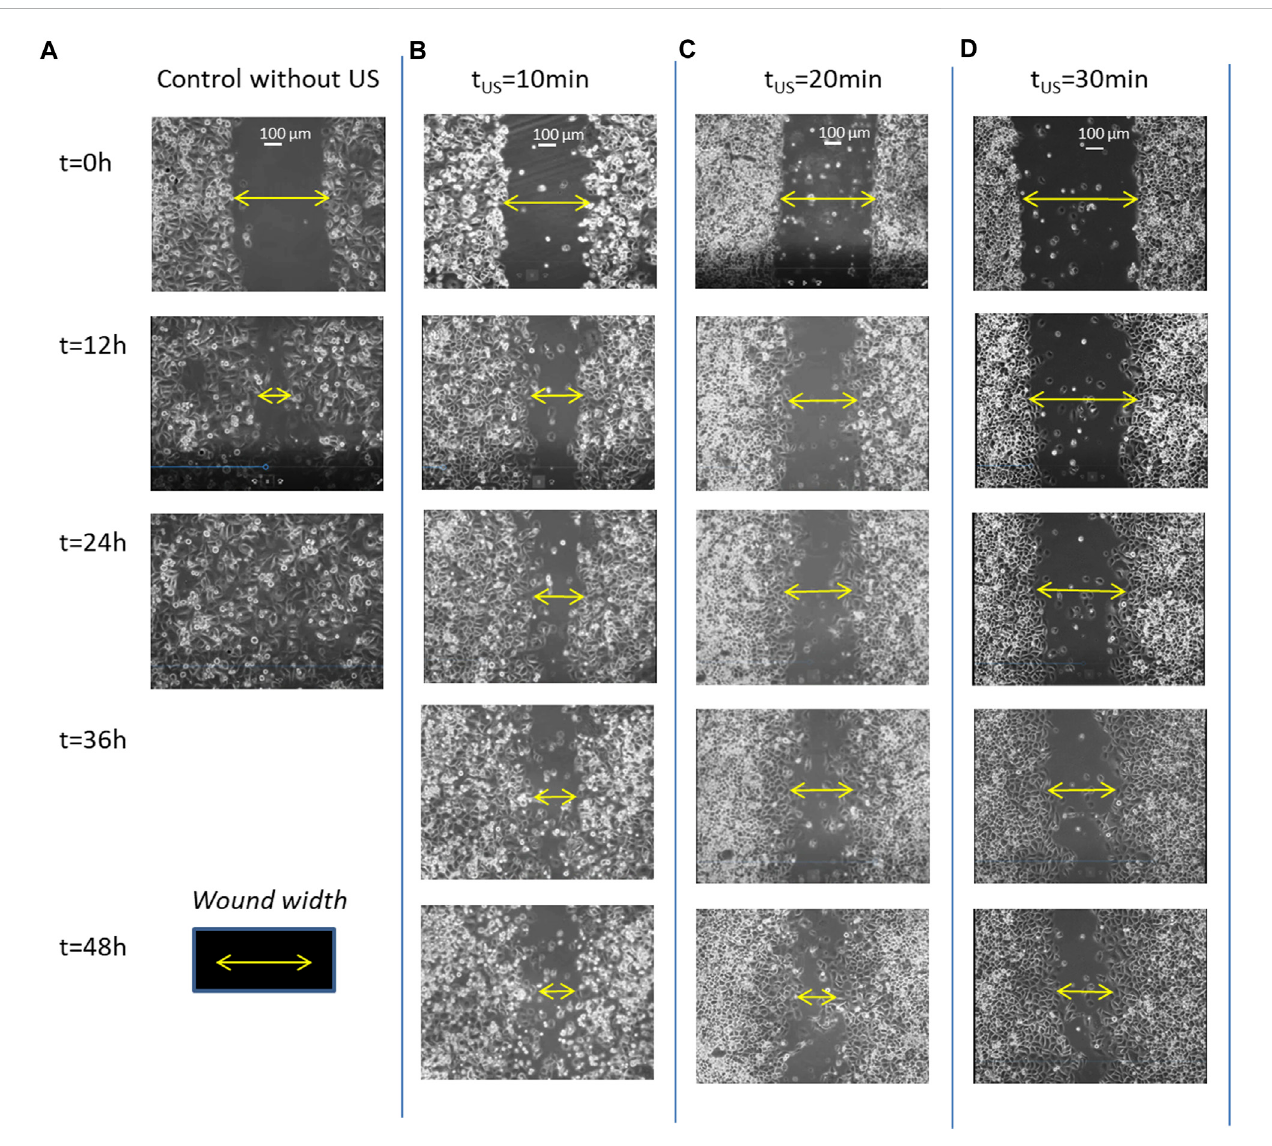
FIGURE 3 Filmed PANC-1 cell migration during wound healing processes: (A) under normal conditions, without ultrasound irradiation; (B) after exposure to LICUs at t US = 10 min; (C) after LICU irradiation at t US = 20 min; (D) t US = 30min before the